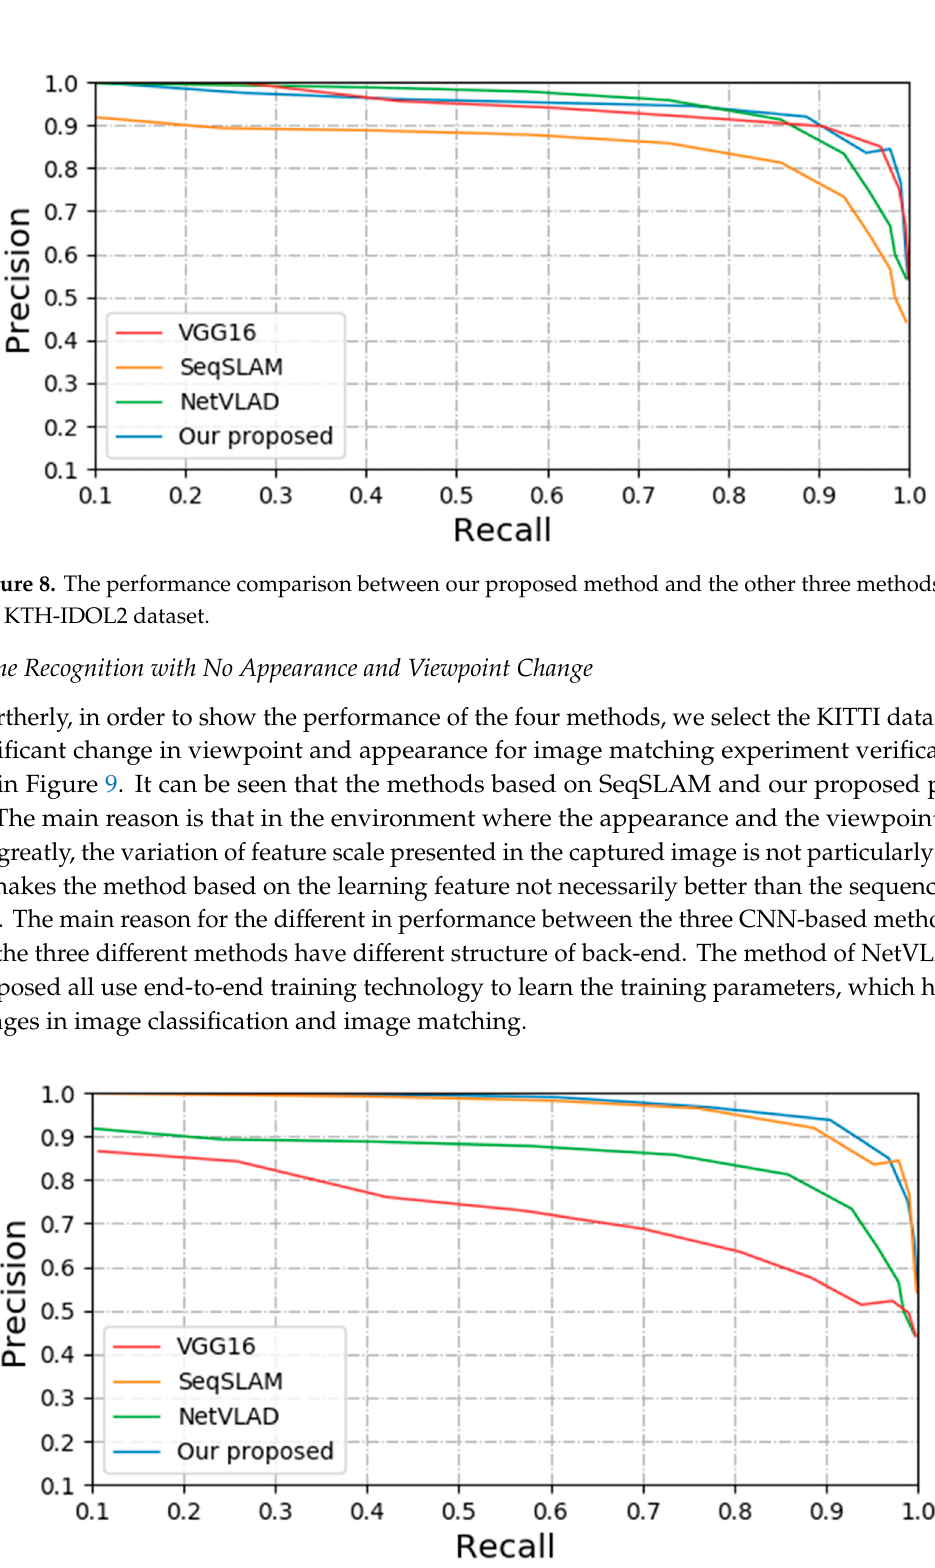
Figure 9. The performance comparison between our proposed method and the other three methods in the KITTI dataset.